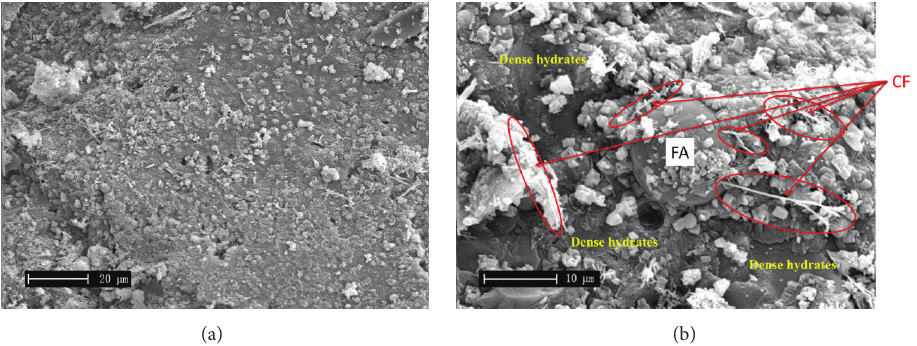
Figure 3: SEM images of microstructure of CFRC at 20 ∘ C at (a) 2000x and (b) 5000x magnification.